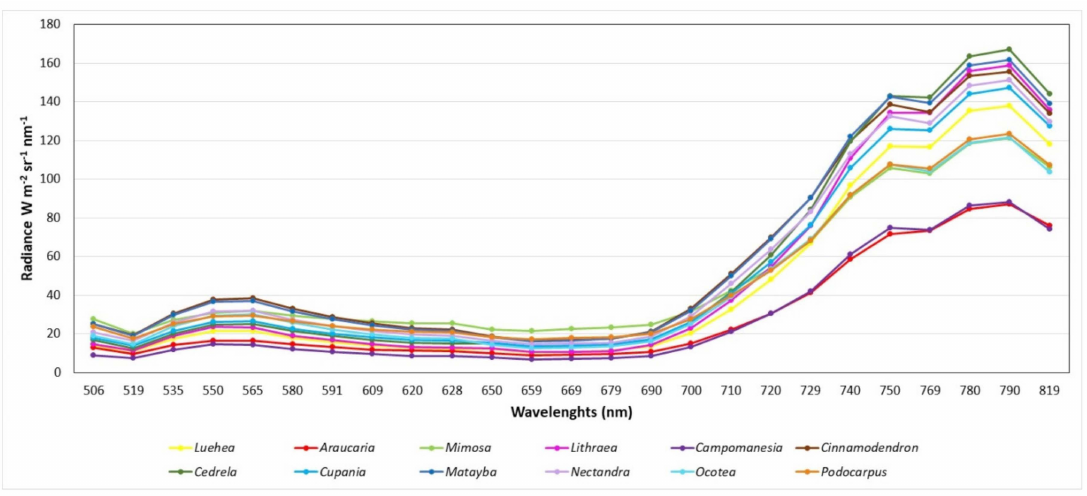
Figure 3. Spectral radiance curves of the tree species obtained by the Fabry–Perot interferometer (FPI) camera.